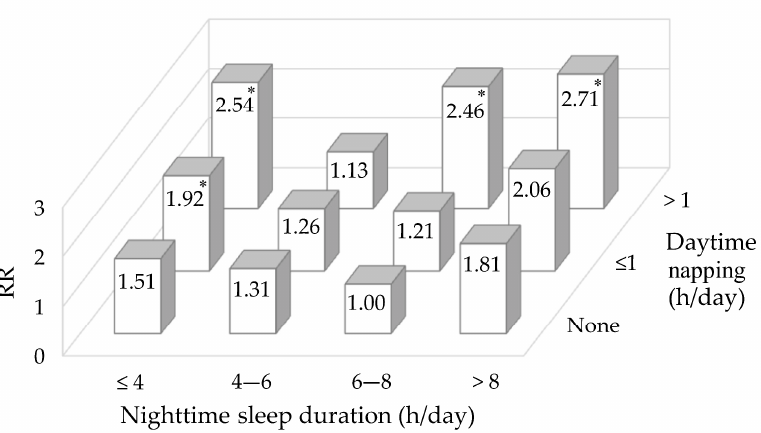
Figure 2. Combined effects of daytime napping and nighttime sleep duration on the risk of diabetes mellitus. * p < 0.05. Adjusted for age, gender, race, education level, area of residence, marital status, drinking and smoking status and systolic BP. Abbreviation: RR: relative risk.